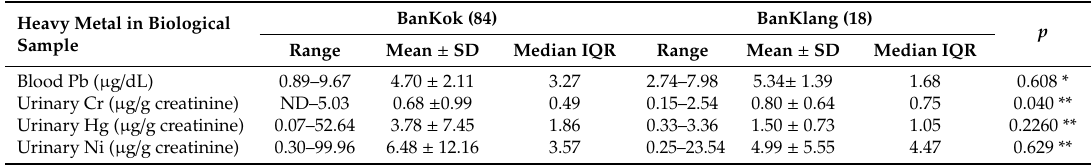
Table 7. Average concentrations of blood lead (Pb) and urinary mercury (Hg), nickel (Ni), and chromium (Cr) in study subjects stratified by location.